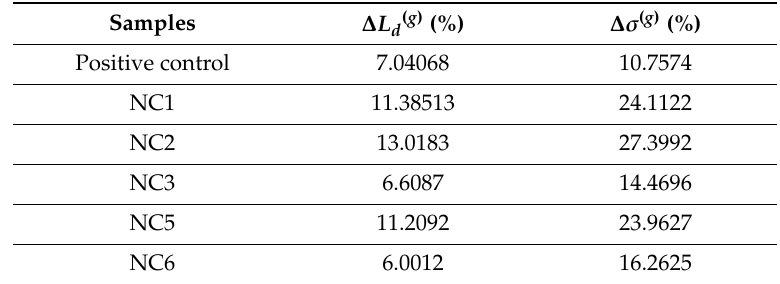
Table 1. Percentage di ff erence in the average disorder strength ( ∆ L d ( g ) ) and standard deviation ( ∆ σ ( g ) ) between control Pseudonomas aeruginosa and treated